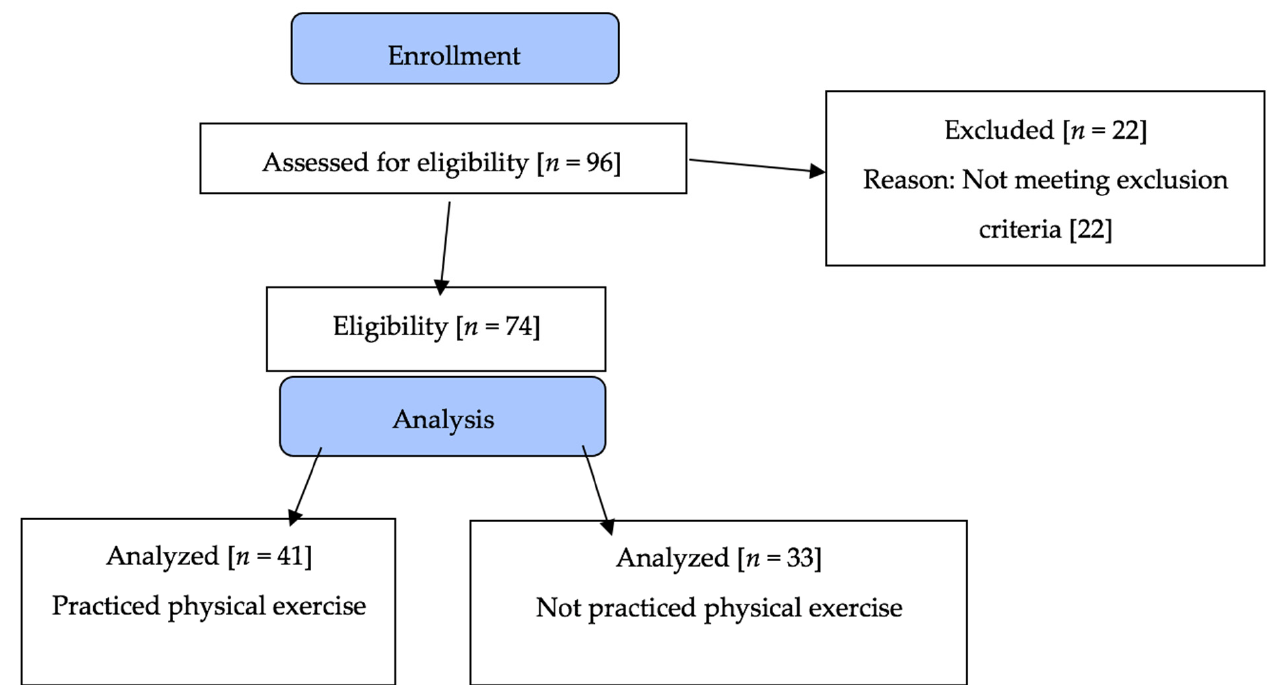
Figure 1. Flow Figure 1. Flow Chart.